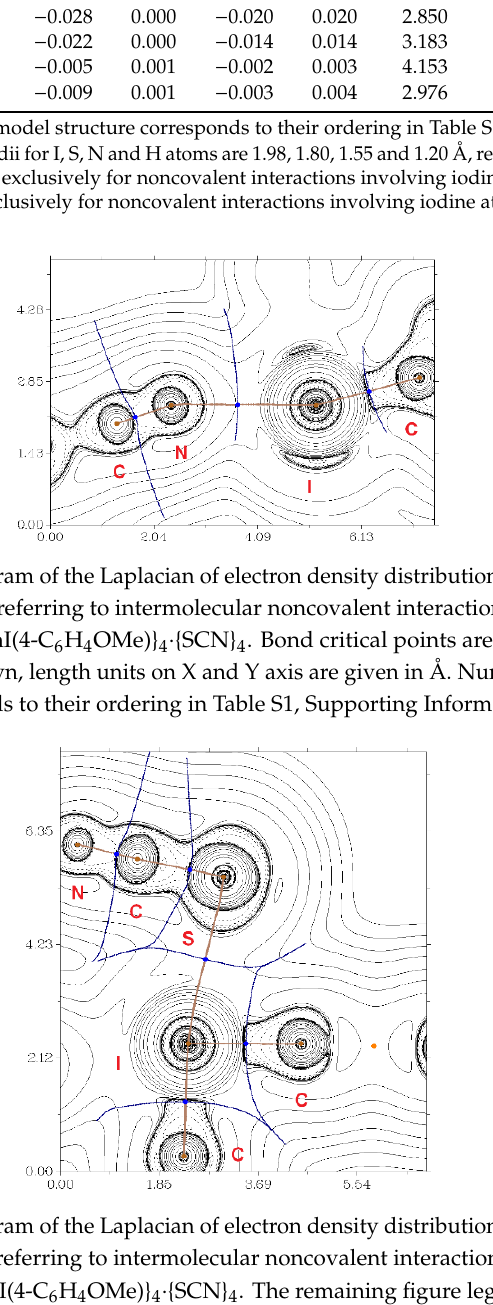
Figure 7. Contour line diagram of the Laplacian of electron density distribution ∇ 2 ρ ( r ), bond paths and selected zero-flux surfaces referring to intermolecular noncovalent interactions I1 ··· S118 in the model heterooctameric cluster {PhI(4-C 6 H 4 OMe)} 4 · {SCN} 4 . The remaining figure legend is in Figure